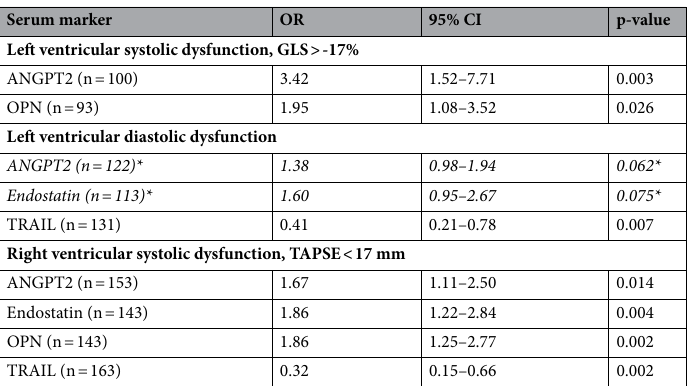
Table 2. Association between echocardiographic ventricular dysfunction and serum markers adjusted for age and sex. ANGPT2 angiopoietin 2, CI confidence interval, GLS global longitudinal strain, OPN osteopontin, OR odds ratio, TAPSE tricuspid annular plane systolic excursion, TRAIL tumor necrosis factor-related apoptosis- inducing ligand. *Indicates numerical associations. HR of ANGPT2, Endostatin, OPN and TRAIL represent an increase of one standard